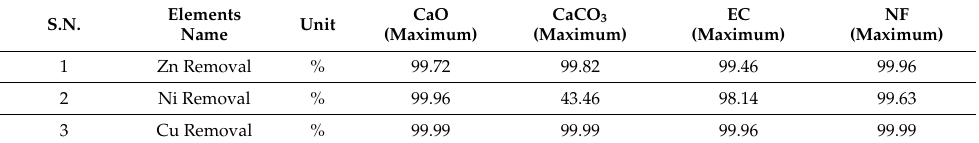
Table 9. Removal% Efficiency of Conventional (CaO and CaCO 3 ) vs. EC and NF processes.